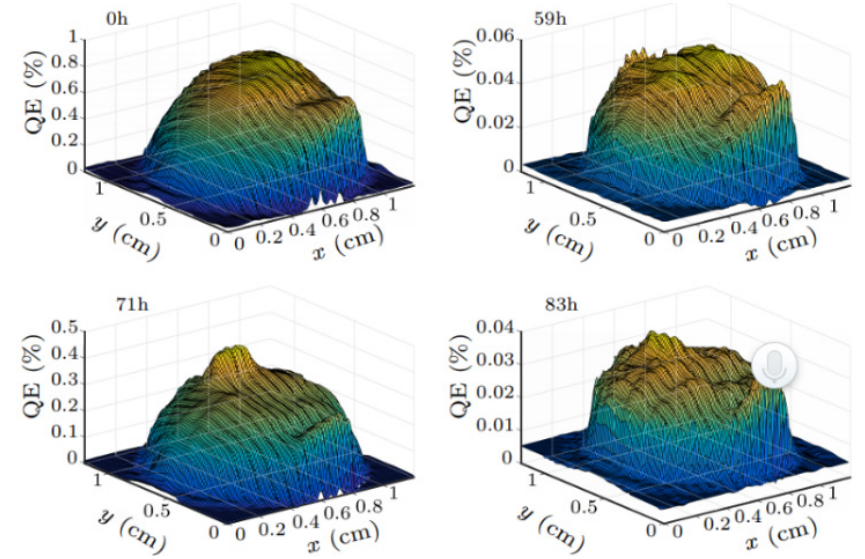
Figure 4. The QE (@532 nm) map of photocathode before and after thermal annealing at SARI [57].